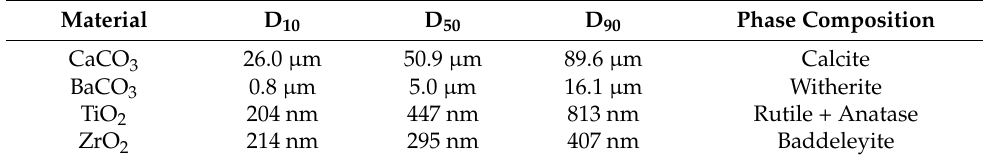
Table 1. Characteristics of the starting powder materials for BCZT